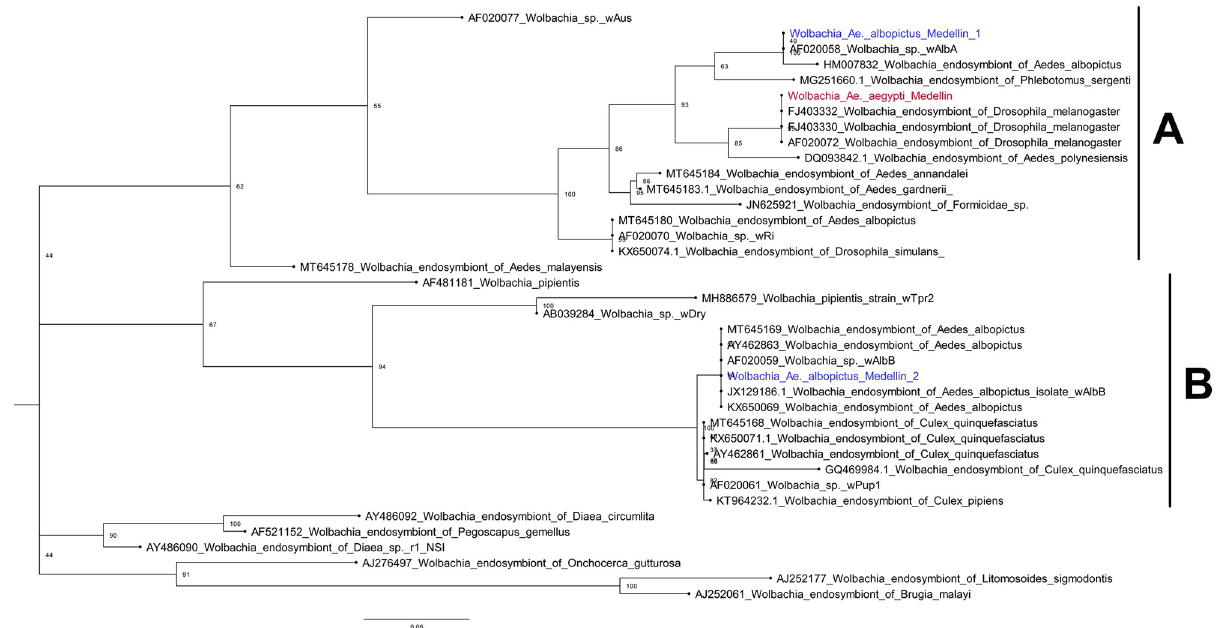
Fig 5. Phylogenetic reconstruction of the Wolbachia consensus sequences associated with Ae . albopictus (blue) and Ae . aegypti (red).